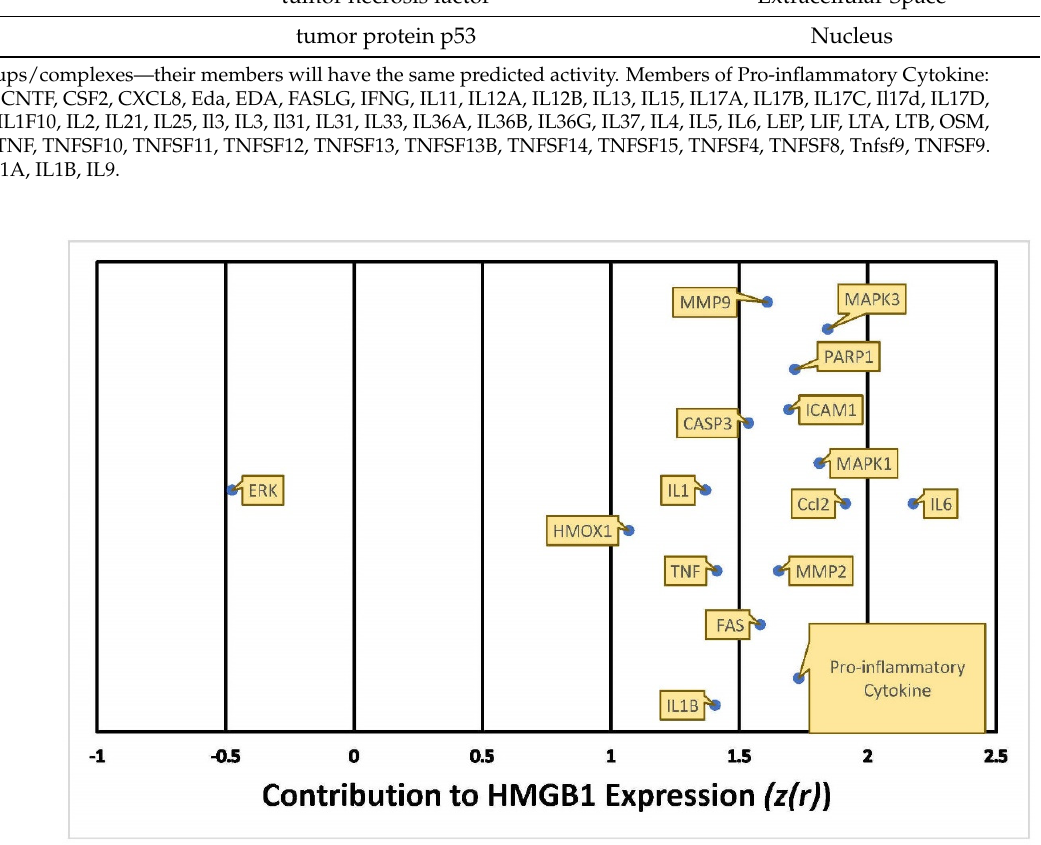
Figure 7. Quantitative illustration of HMGB1 expression in response to METH exposure. The overall change in expression in HMGB1 in response to METH exposure was measured by the individual involvement, Z-score (z(r)), of each of the 16 intermediate molecules.